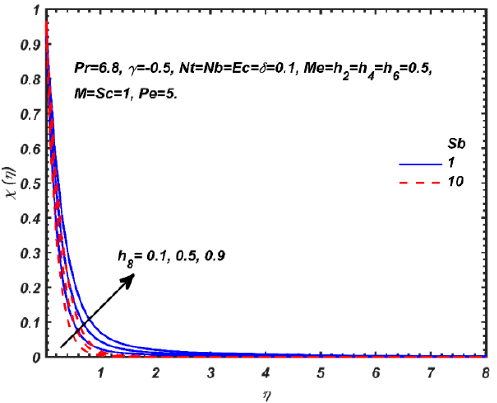
h and Sb on the dimensionless micro-organism density number function. Figure 5. E ff ects h 8 and Sb on the dimensionless micro-organism density number Figure 5. Effects 8